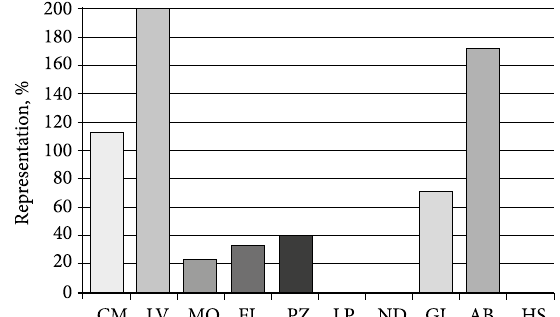
Fig. 6. Representation of soil types in the EU 28 and in biochar field trials. See Table 1 for the meaning of the soil codes. 100% means that the proportion of field sites is the same as the proportion of the agricultural area for the EU28. A representation value >100% indicates over-representation, and a value <100% indicates under-representation (Feb.